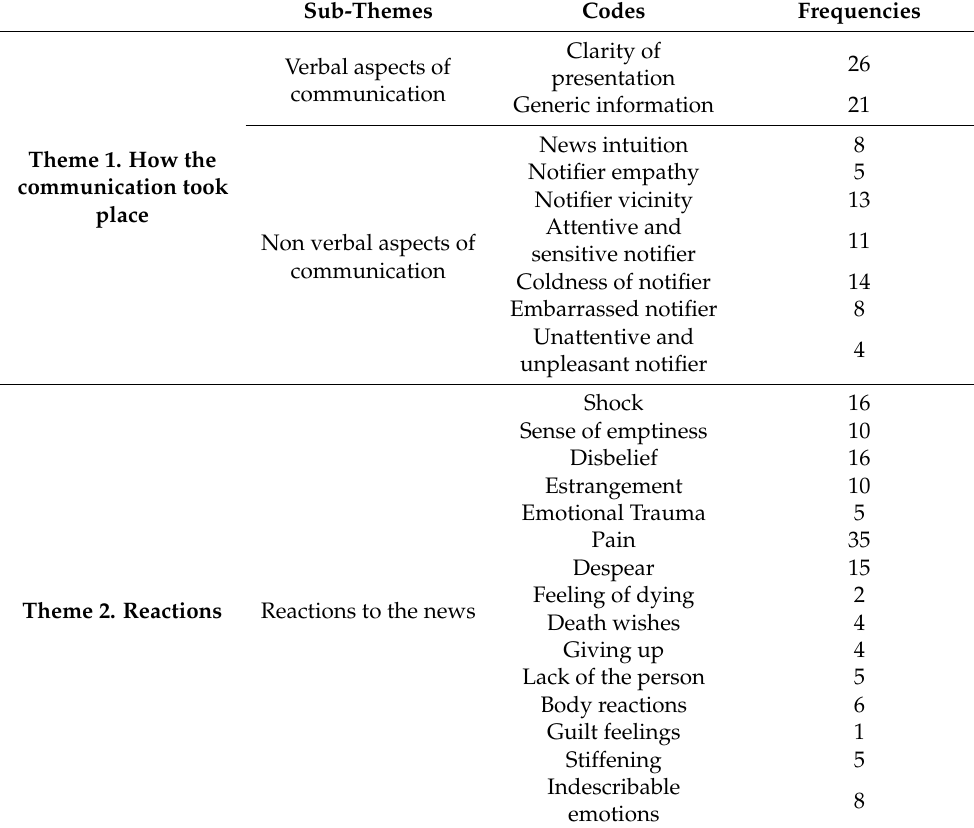
Table 3. Themes, sub-themes, codes and frequencies observed in the